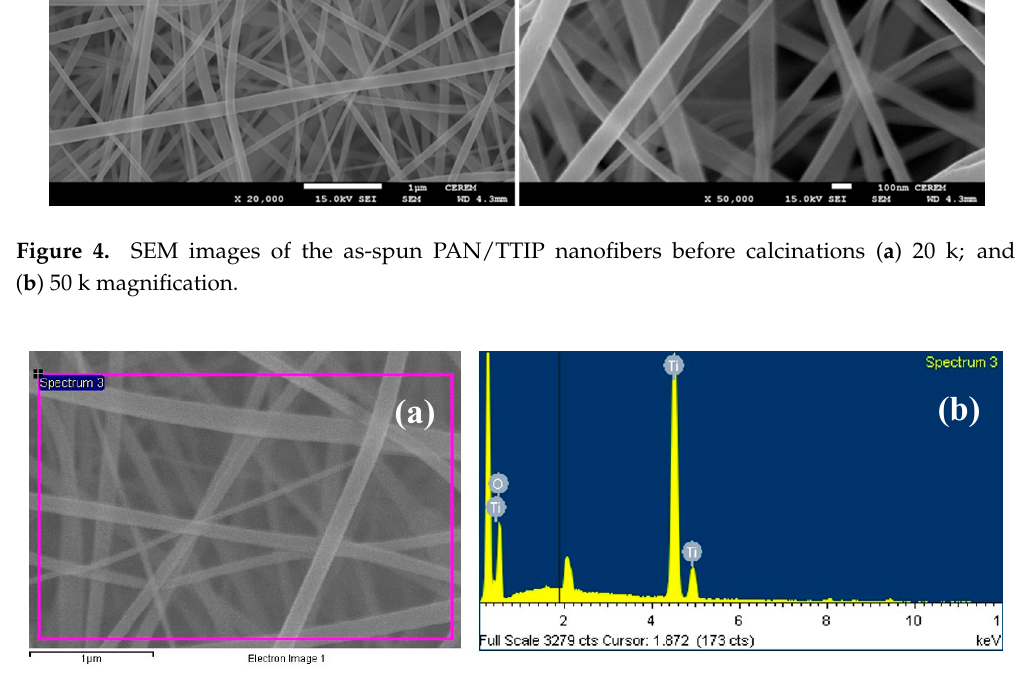
Figure 4. SEM images of the as-spun PAN/TTIP nanofibers before calcinations ( a ) 20 k; and ( b ) 50 k magnification.